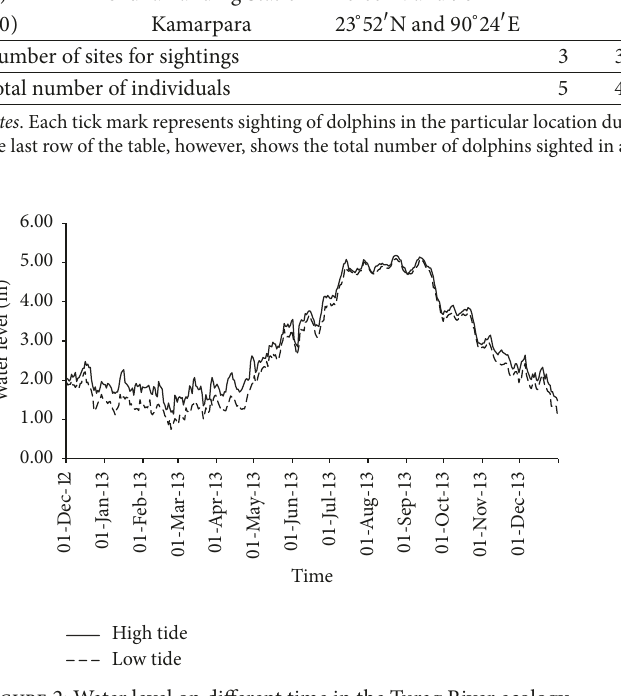
Figure 2: Water level on different time in the Turag River ecology.